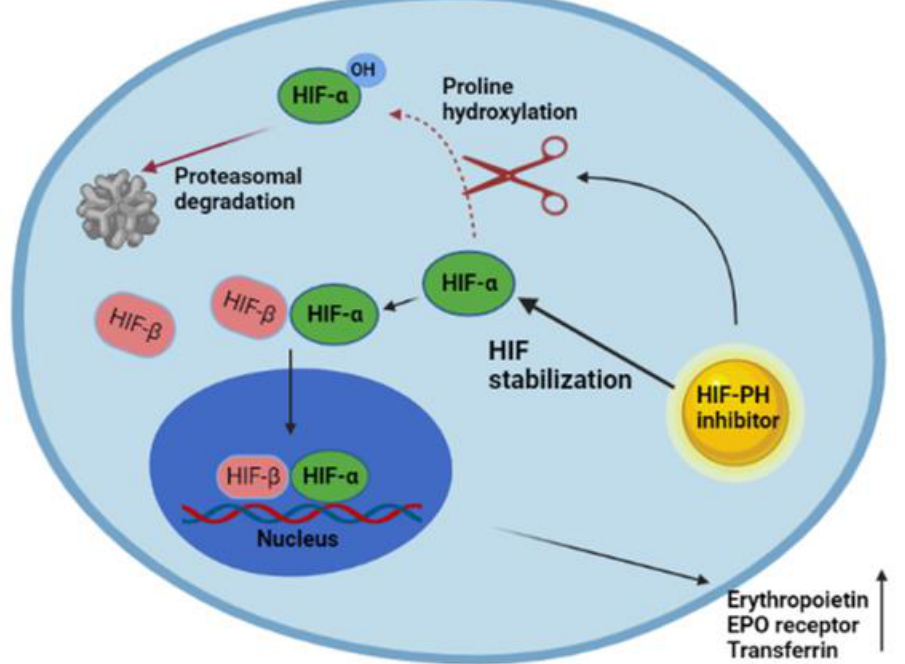
Figure 1. Mechanism of action of HIF stabilizers. Under normal conditions, the activity of HIF-PH leads to the rapid degradation of HIF. During hypoxia, HIF-PH activity is instead suppressed, re- sulting in stimulation of endogenous EPO production, increased expression of the transferrin recep- tor, better use of iron with consequent maturation of erythrocytes, and an increase in hemoglobin levels. Similarly, the use of HIF stabilizers results in a steady increase in dose-dependent hemoglo- bin levels, including reducing hepcidin and ferritin levels and improving iron binding capacity.